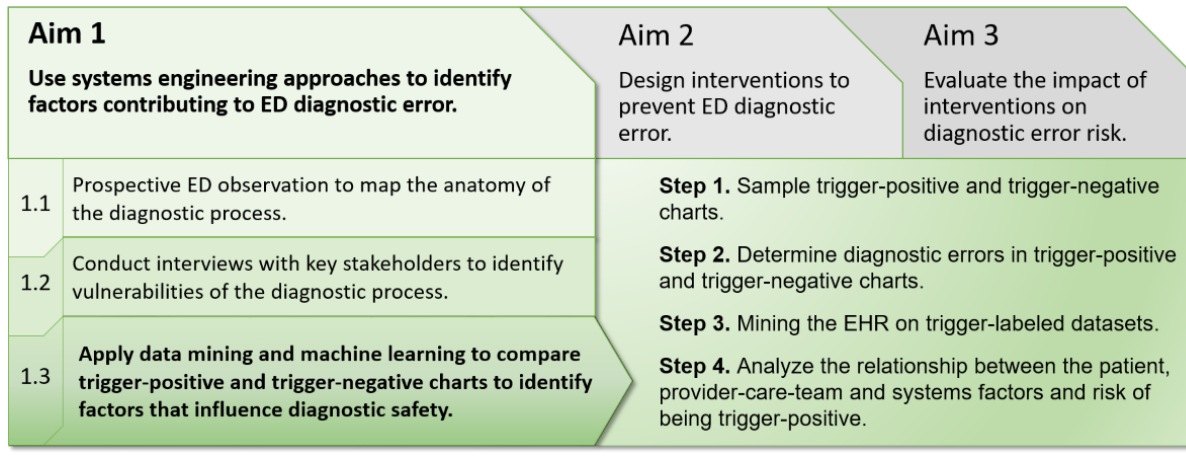
Figure 1. The 3 aims of the Agency for Healthcare Research and Quality-funded Improving Diagnosis in Emergency and Acute Care–Learning Laboratory project and the detailed steps of this study specifically focusing on aim 1.3 to identify patient-, provider-care team–, and system-level–factors affecting the risk for diagnostic error. ED: emergency department; EHR: electronic health